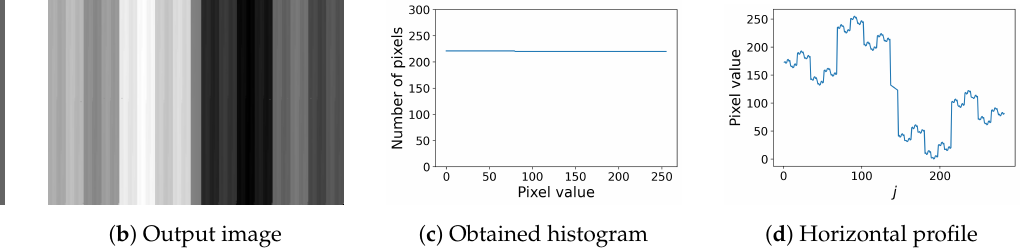
Figure 8. Nikolova and Steidl’s exact histogram equalization: ( a ) input image with 200 × 282 pixels, where the dark and bright areas have pixel values 100 and 200, respectively. ( b ) vertical stripes are generated in the output image; ( c ) the obtained histogram confirms that Nikolova and Steidl’s method exactly equalizes the histogram; ( d ) horizontal profile in ( b ) shows the fluctuation of pixel values, but it preserves the original ordering in ( a ).